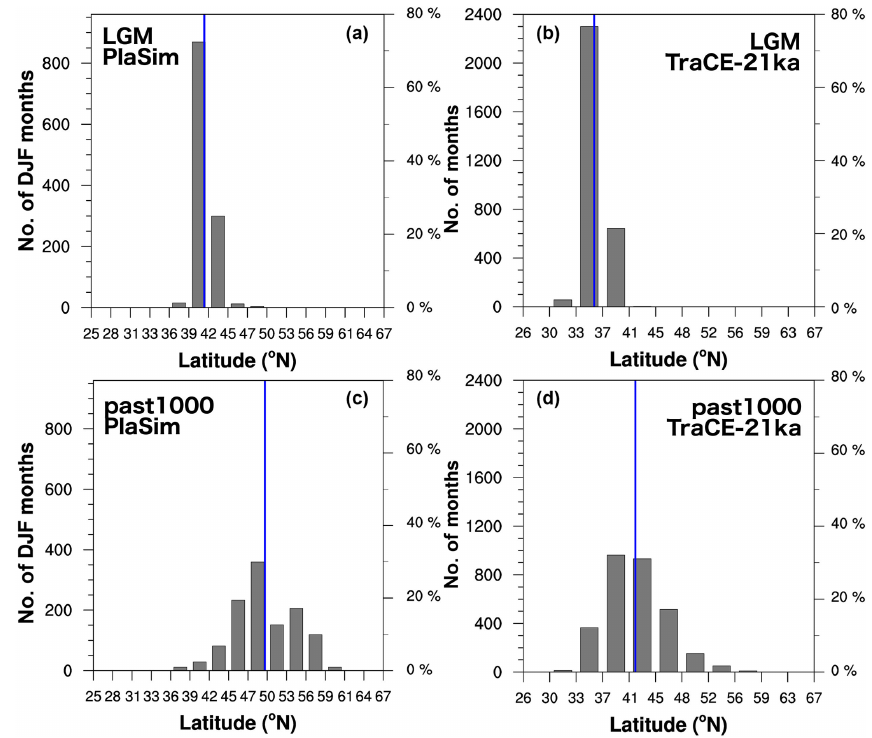
Figure 6. Histograms of latitudes corresponding to peak NAtl zonal winds for all PlaSim ensemble members (a, c) and the TraCE-21ka data (b, d) during indicated periods. Monthly jet latitude statistics are aggregated over 100 simulation years and four ensemble members for PlaSim and 1000 simulation years for the TraCE-21ka simulation. Vertical blue lines indicate mean jet latitudes for the time